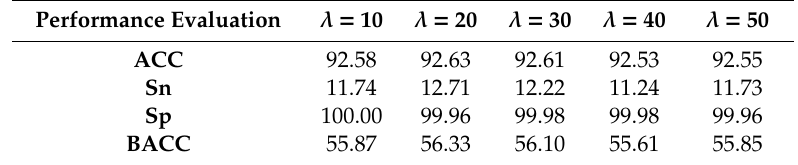
Table 3. The prediction overall accuracy of ECM proteins by selecting di ff erent λ values.